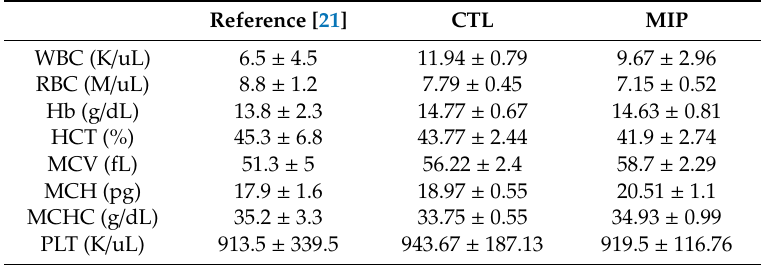
Figure 8. Hematoxylin and eosin ( H&E) staining of rat tissues after 28 day subacute oral toxicity experiment with MIPs (40×; scale bar: 100 μm). CTL: control; MIP: mesoporous iron particles. Table 2. Biochemical values of rats after 28 day sub-acute oral toxicity experiment with MIPs. Table 1. Hematology values of rats after 28 day sub-acute oral toxicity experiment with MIPs.